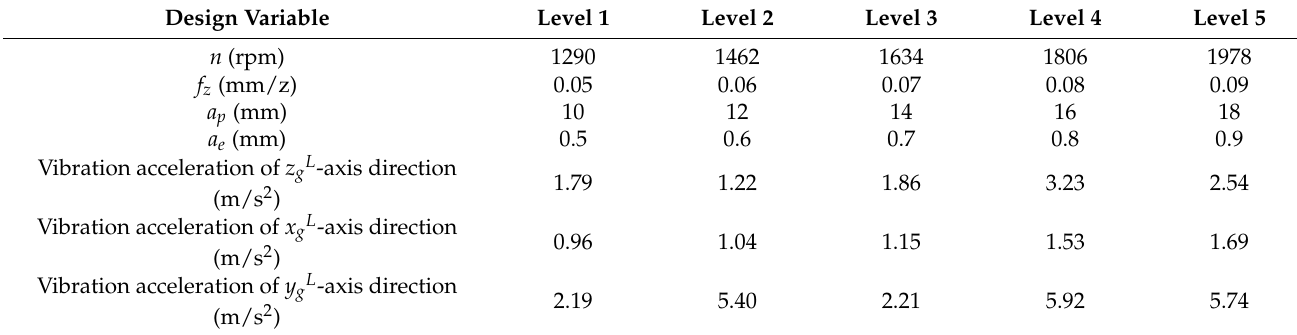
Table 2. Process design variables of the machined surface error.